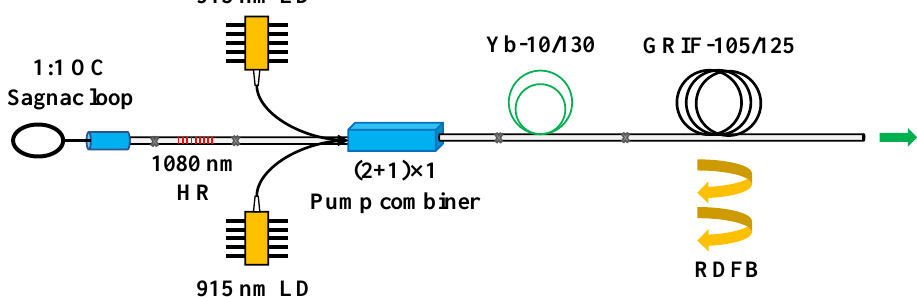
Figure 1. Schematic diagram of the intra-cavity Raman fiber laser.